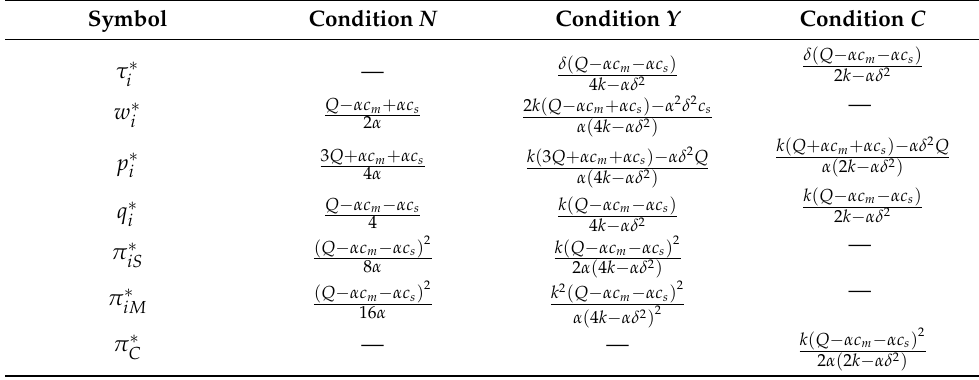
Table 2. The comparison of the optimal solutions of variables in three eco-design